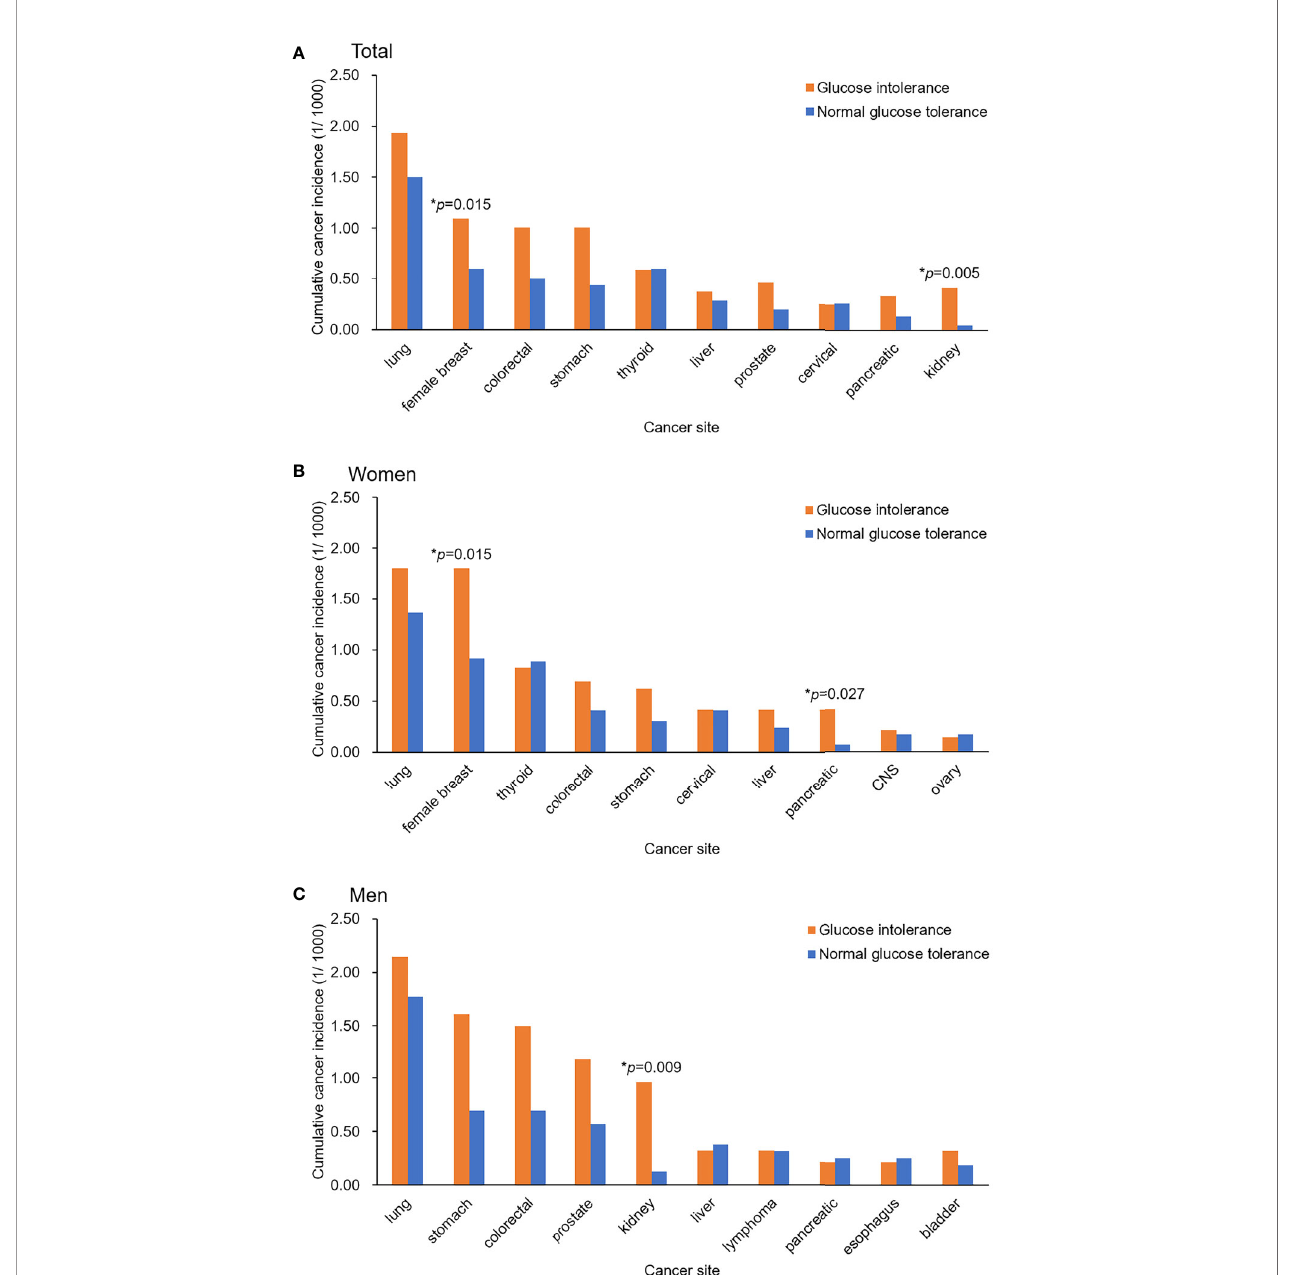
FIGURE 1 | Cumulative incidence rates of the top 10 site-speci fi c cancers during the follow-up among the study participants with different baseline glycemic status. (A) Total participants, (B) Women, (C) Men. Differences in the cumulative incidence rates were tested using a Cox proportional hazards model, adjusted for age and